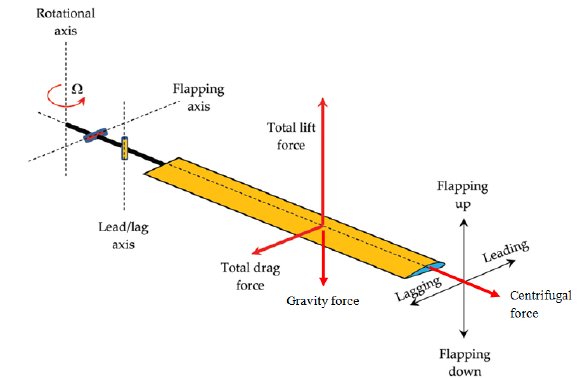
Figure 1. Aerodynamic & structural forces on helicopter rotor